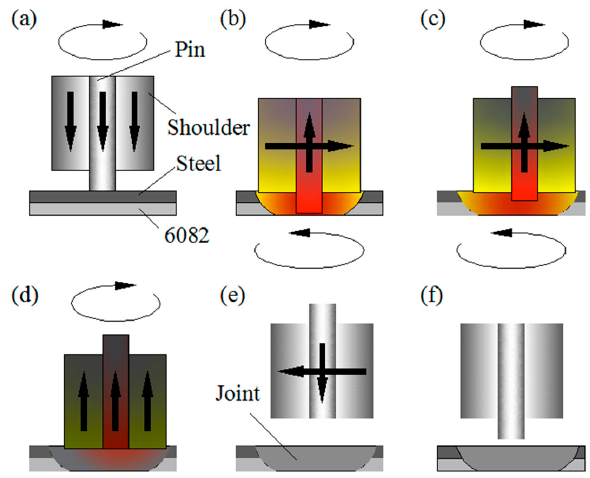
Figure 1. Welding process of the rotary retractile keyhole-free FSSW (Fiction Stir Spot Welding).